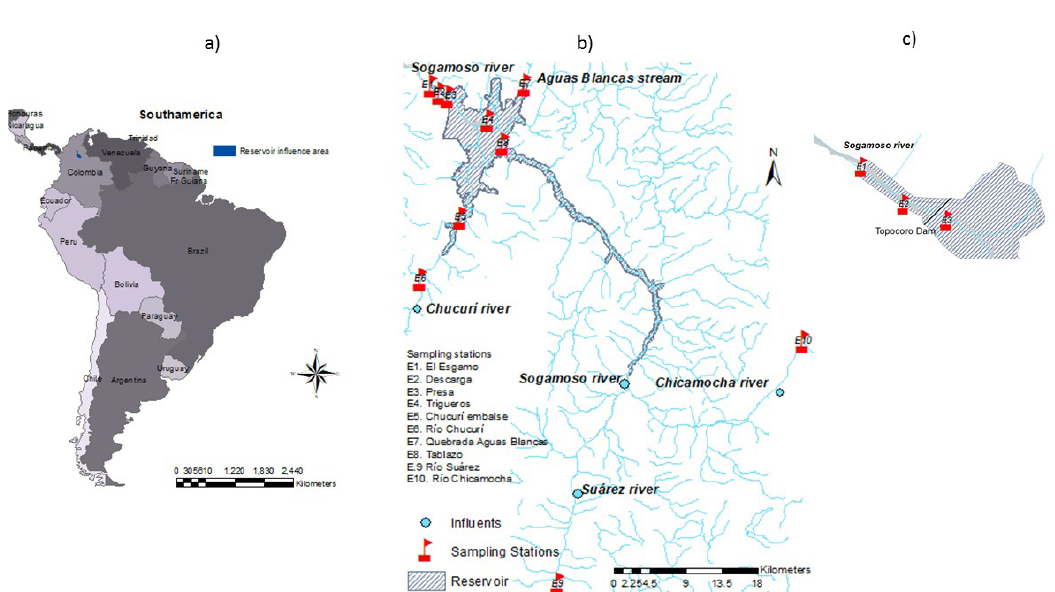
Figure 1. Study area: a) Colombia in South America; b) Hidrosogamoso reservoir an sampling stations; c) Hidrosogamoso dam (Topocoro).